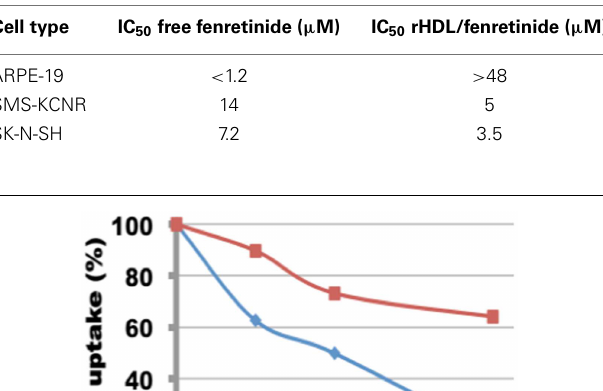
Table 2 | Percentage retention of FR in rHDL-FR nanoparticles when exposed to different storage conditions.